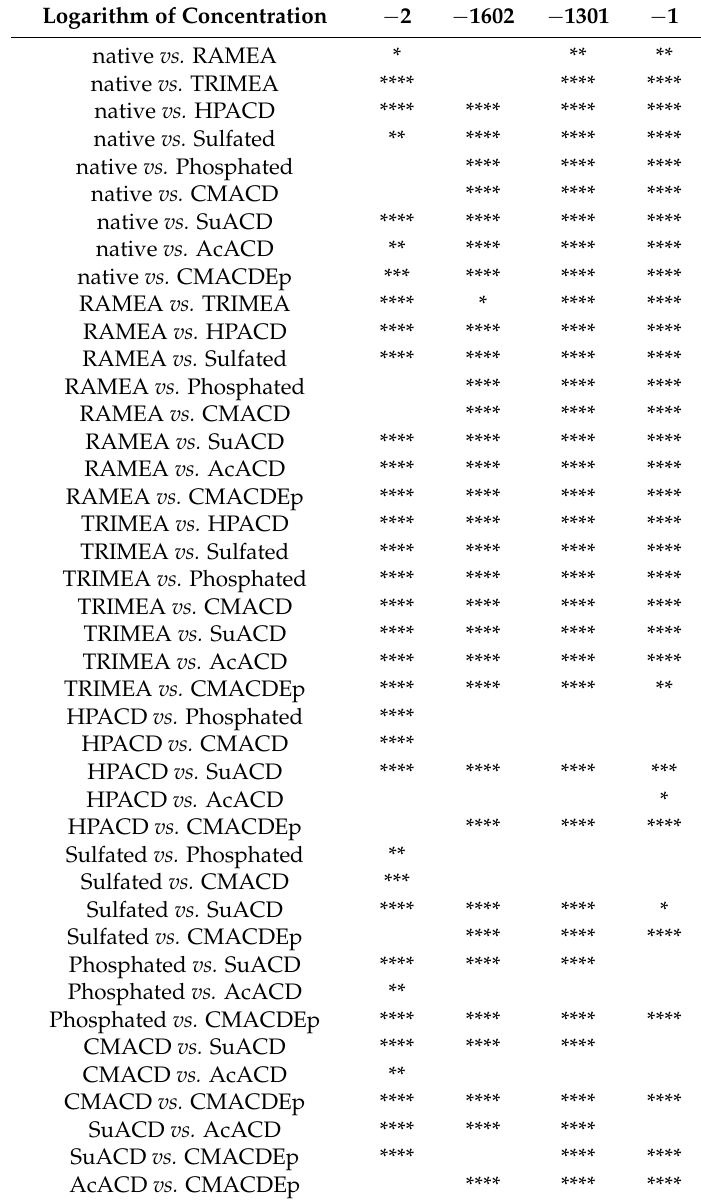
Table 4. Comparison of hemolysis values among the groups treated with different α -CD derivatives (the number of asterisks indicates the level of statistical significance. p < 0.005 (*), p < 0.001 (**), p < 0.001 (***), p < 0.0001